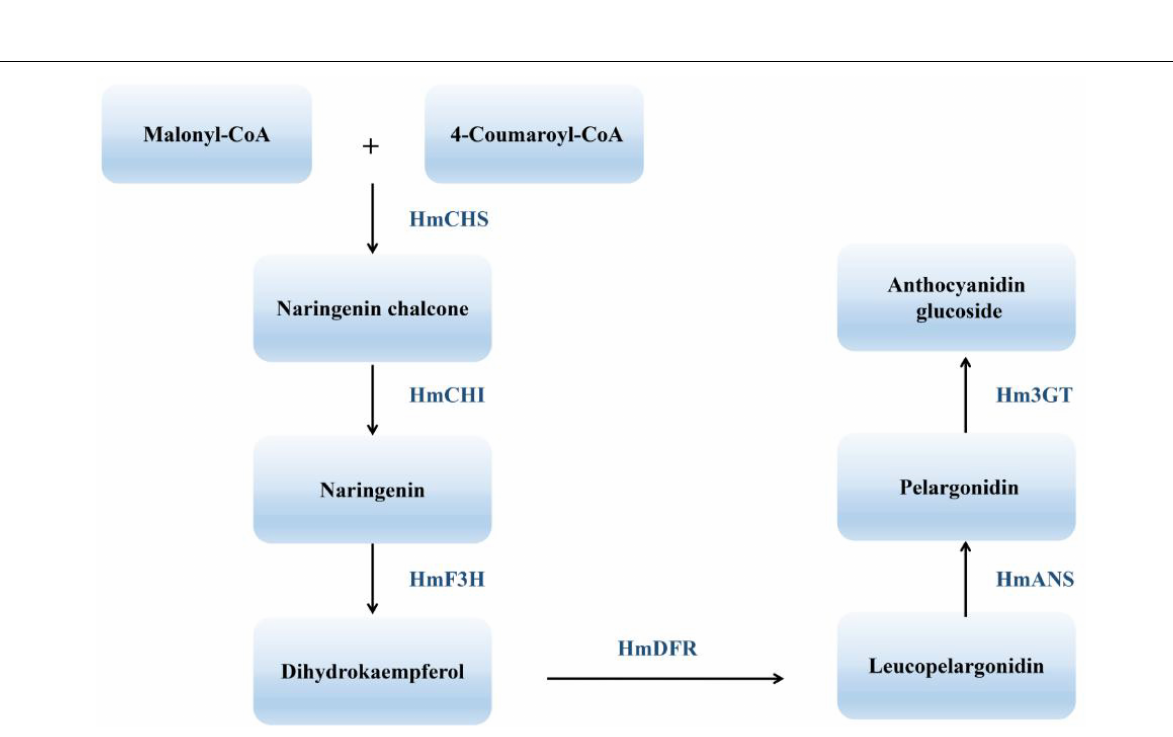
Frontiers in Plant Science |